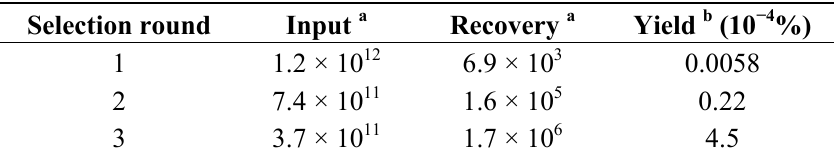
Table 1. Enrichment of the morphine-binding